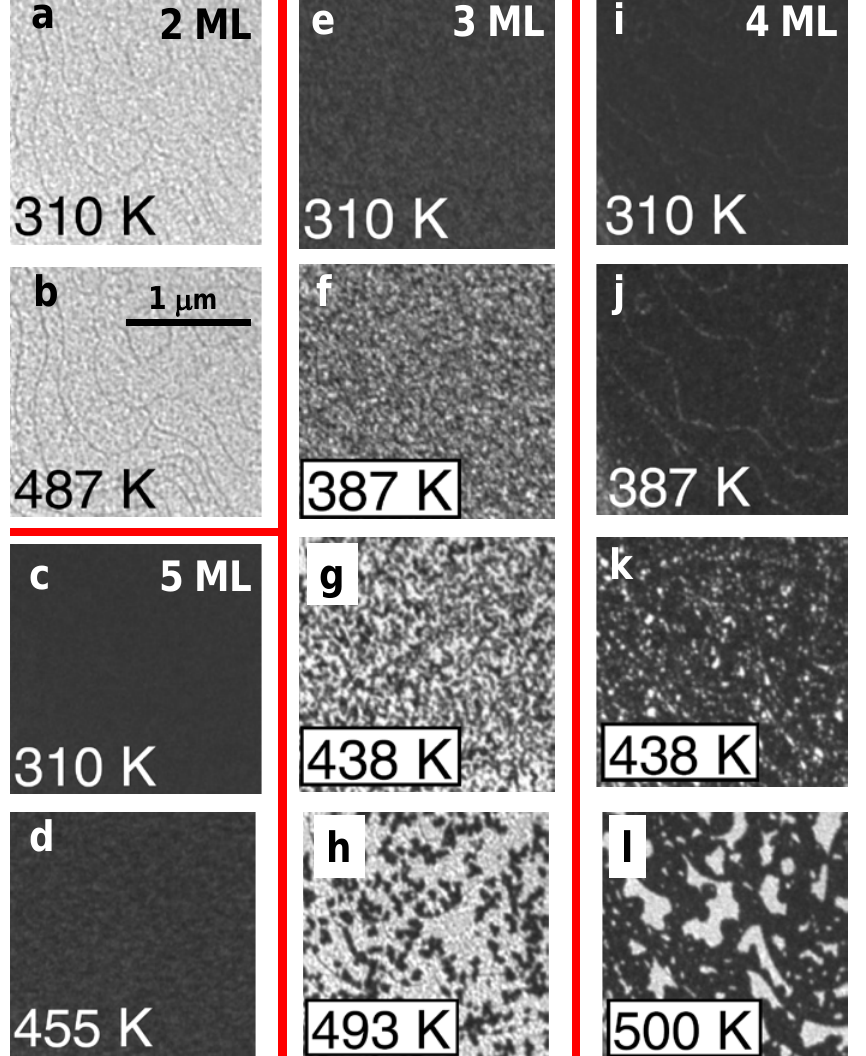
Figure 8. LEEM images of initially [(a) and (b)] 2 ML, [(c) and (d) 5 ML, [(e) to (h)] 3 ML, and [(i) to (l)] 4 ML Ag films at the temperatures indicated during annealing. Adapted from [32] (Copyright American Physical Society